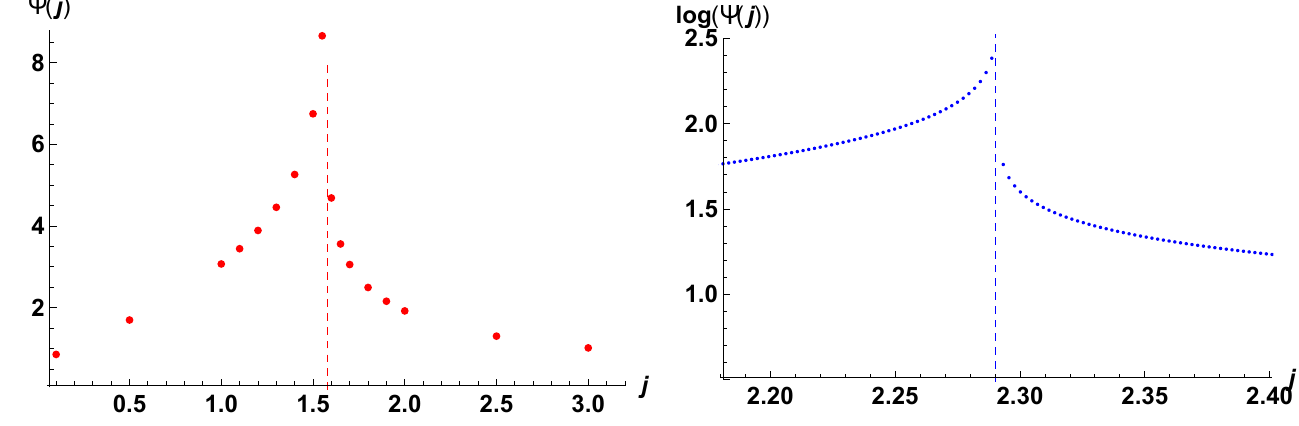
Figure 4. ( Left Panel ) Numerical estimates of periastron coordinate Ψ ( j ) for ω = − 1 of log Ψ ( j ) for ω = + 1 3